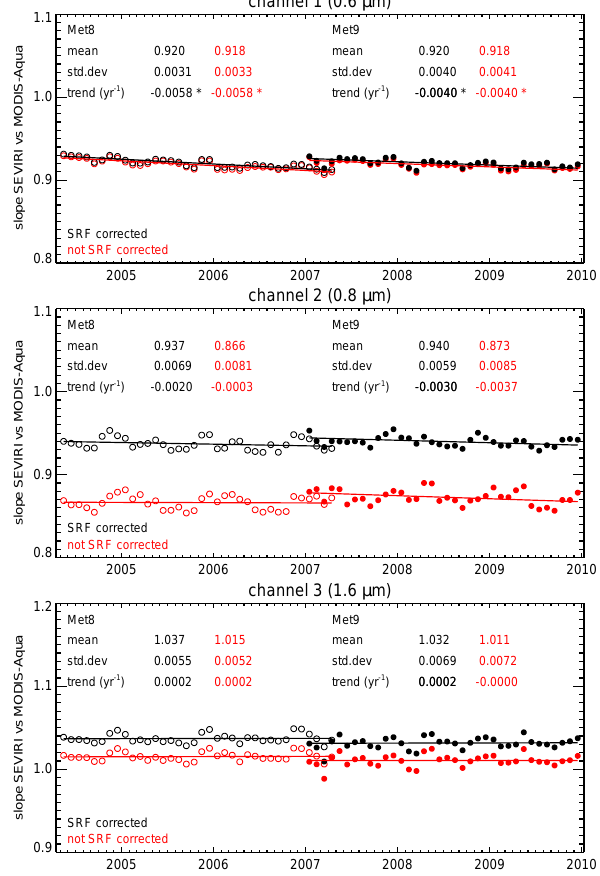
Fig. 5. Time series of inter-calibration slopes for SEVIRI-Meteosat against MODIS-Aqua for three solar channels. The open circles are the monthly slopes for Meteosat-8, while the filled circles are for Meteosat-9. The solid lines are linear fits through those monthly slopes. Black symbols and lines correspond to data that have been corrected for SRF differences, while red symbols and lines corre- spond to data that have not been corrected for SRF differences. Mean, standard deviation (relative to the trend line), and trend of the inter-calibration slopes are indicated in the plots. Trends that are significant at the 95% level are marked by an